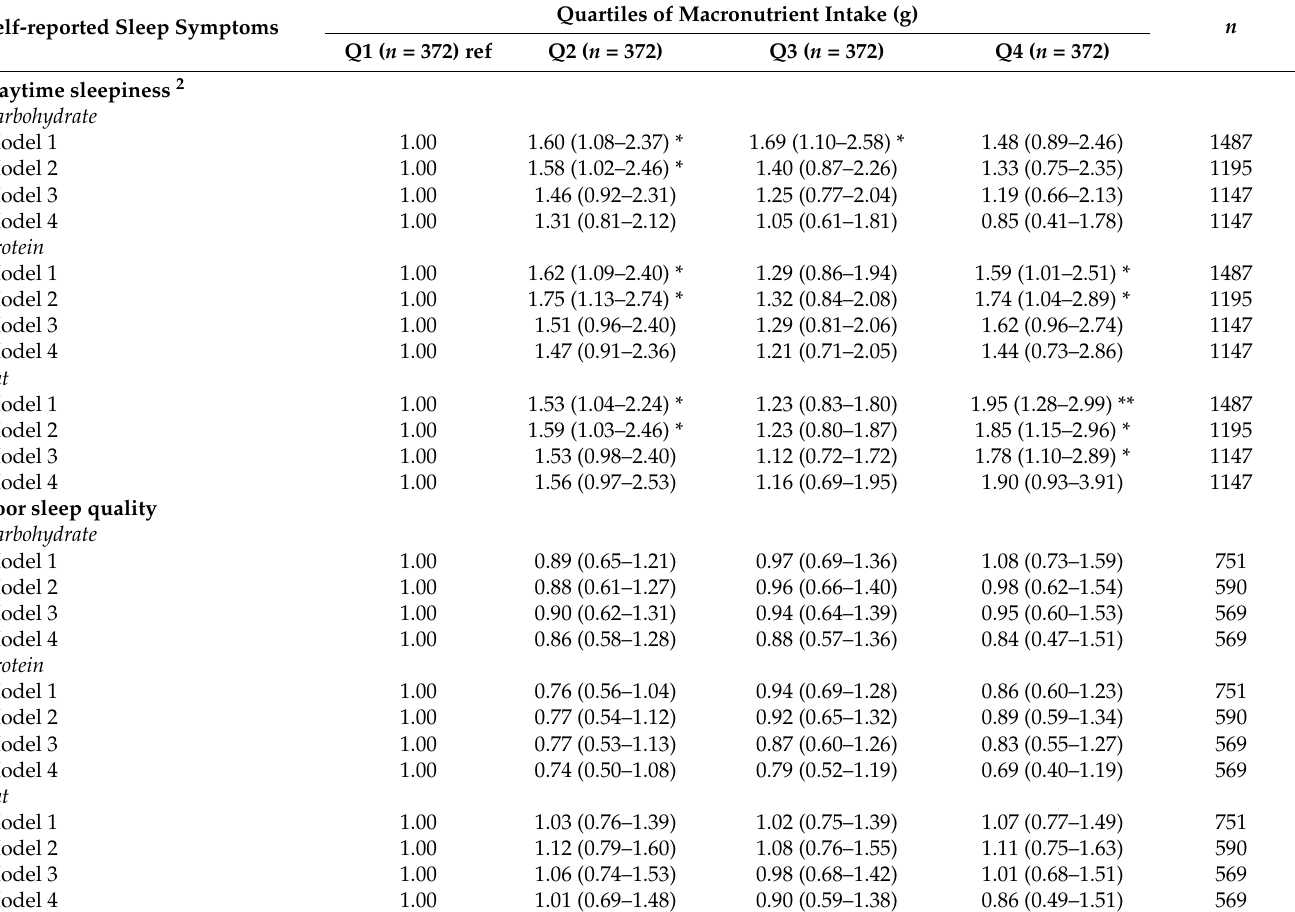
Table 3. The prevalence ratio (95% CI) for self-reported sleep parameters across quartiles of macronutrient intakes 1